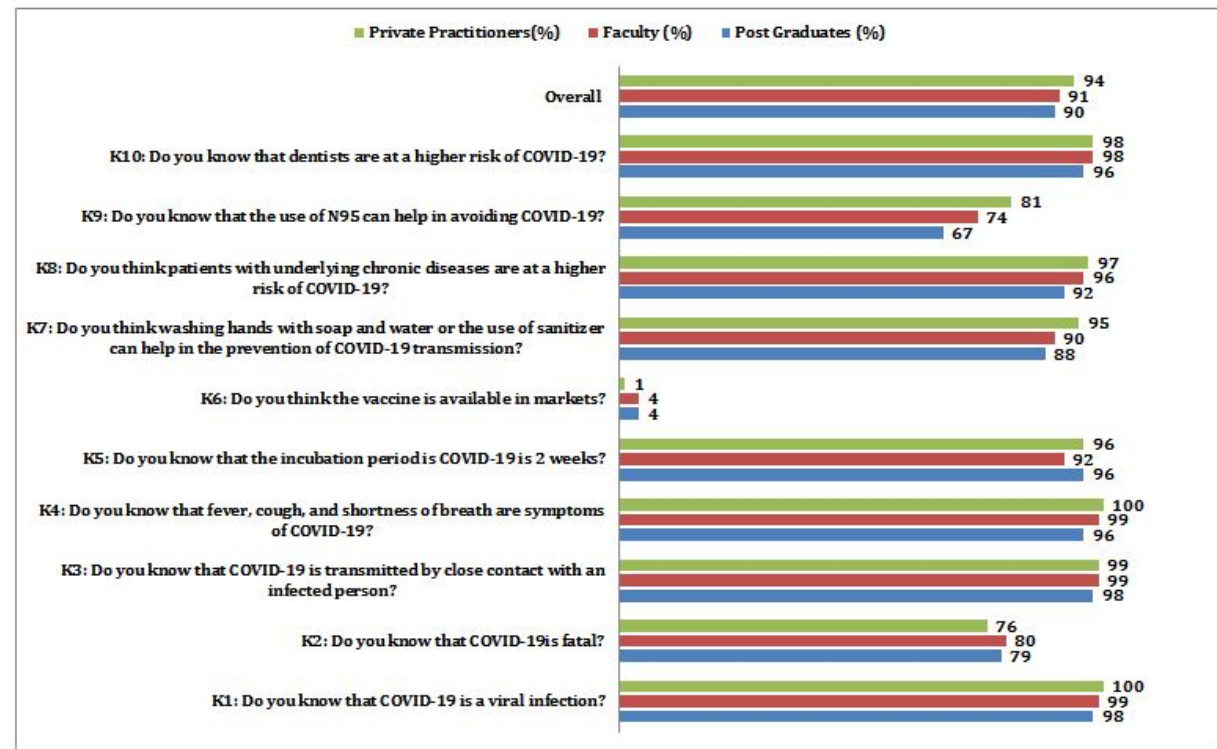
Figure 3. Overall knowledge scores (%) of pediatric dentists participated in the study.